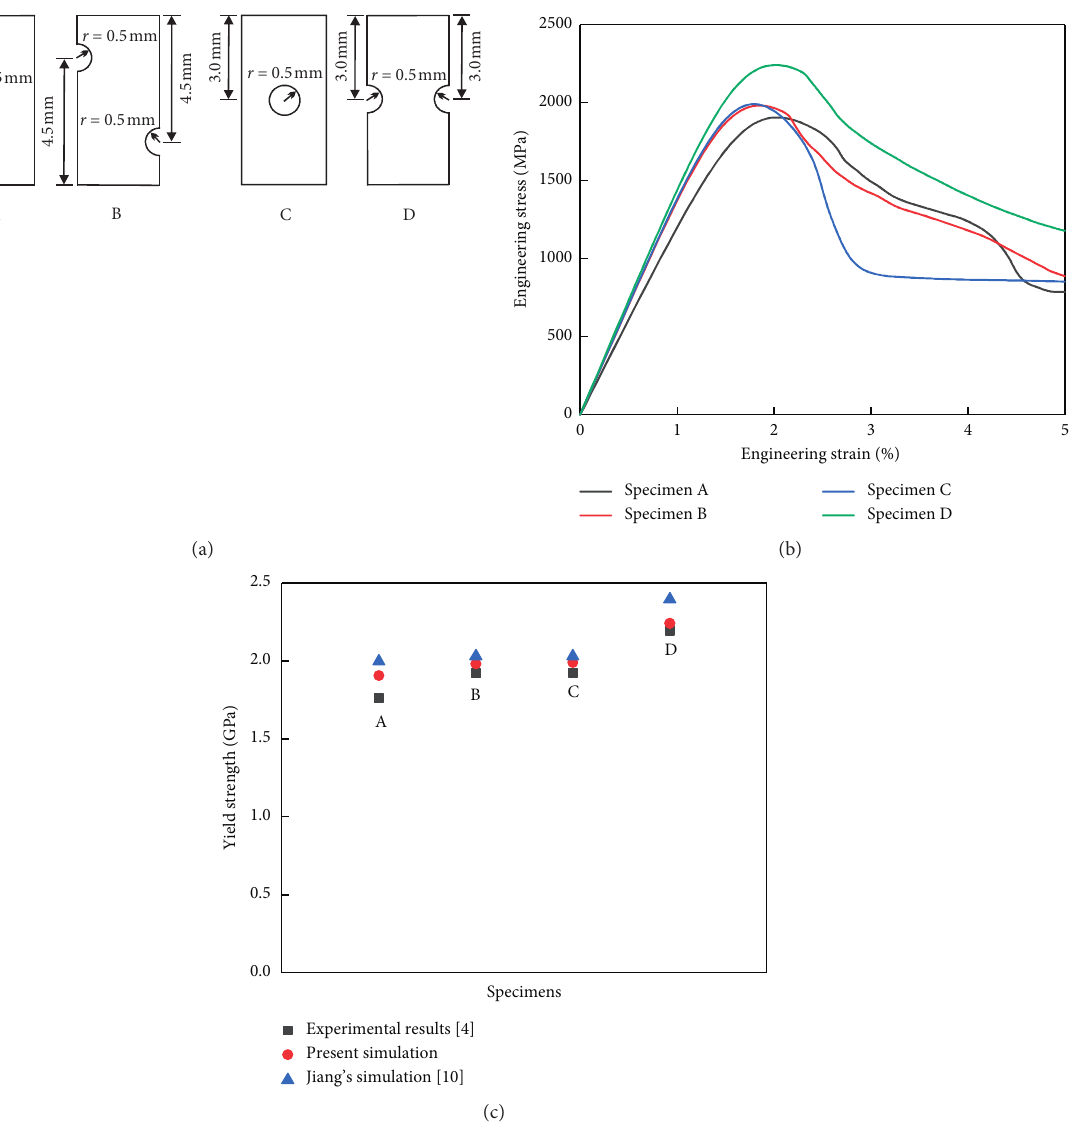
Figure 5: (a) Configuration of notched specimens [4]. (b) Engineering stress-strain curves for four notched specimens under compressive loading. (c) Comparison of yield strength for all the four notched specimens along with experimental results [7] and Jiang’s simulation [16]. Obvious strength and plasticity improvement are found on sample with two symmetric notches (specimen